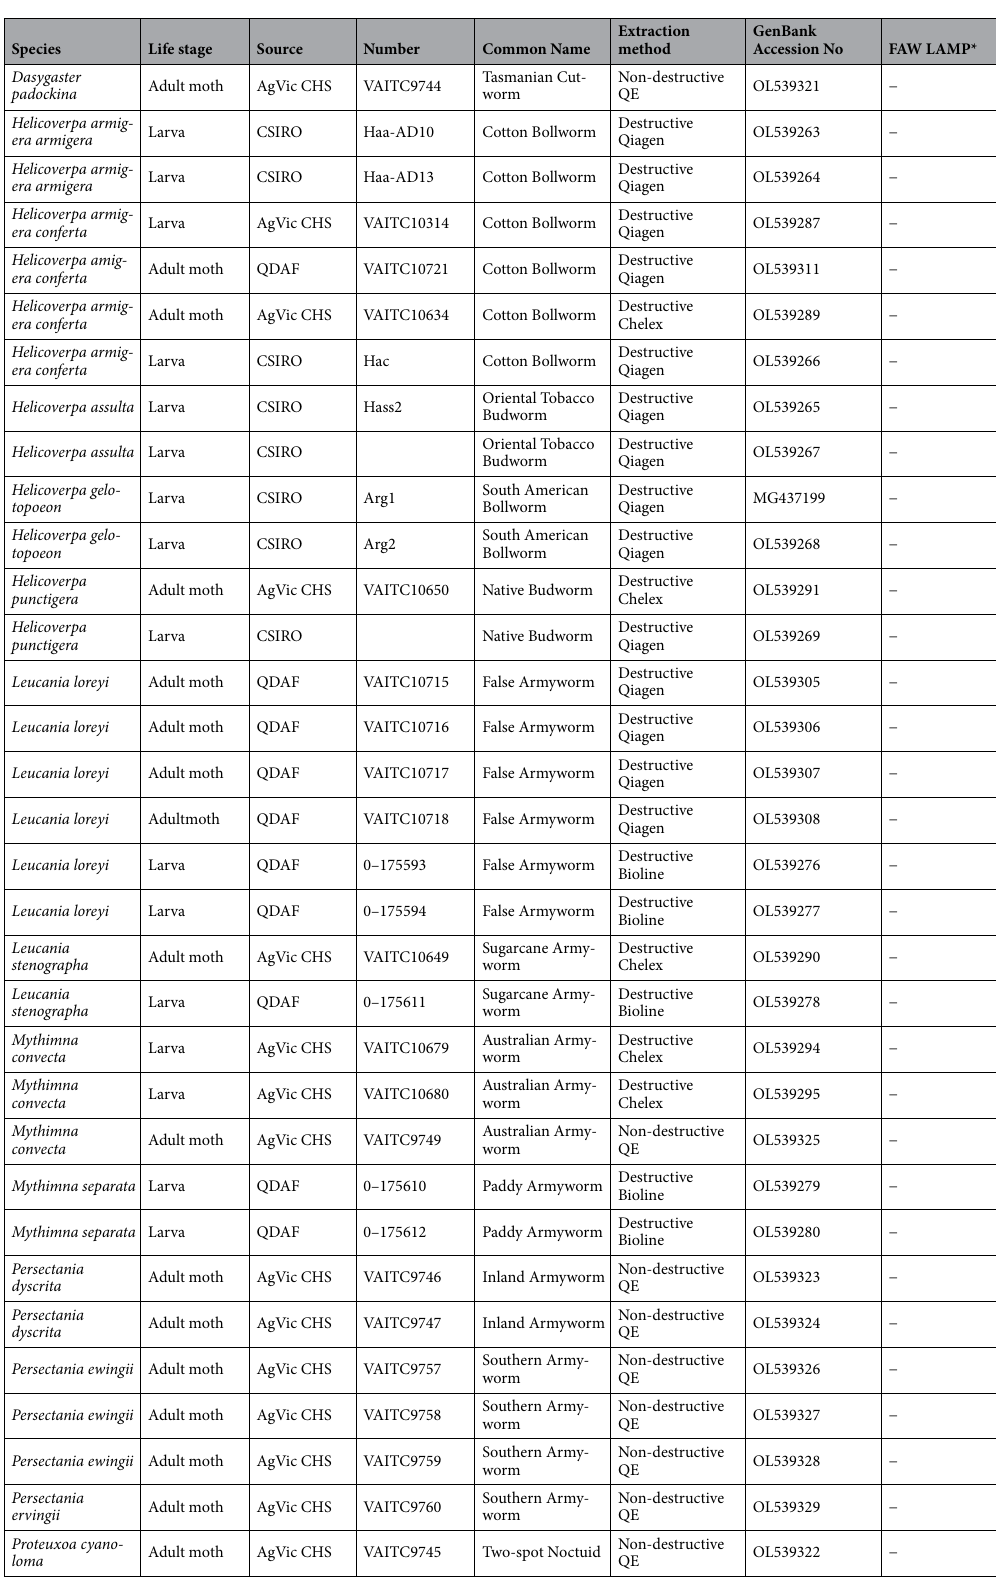
Table 2. Panel of Noctuidae (Lepidoptera) specimens tested for the FAW LAMP assay. Bold indicates the target species. “ + ” indicates FAW LAMP amplification within 20 min, “−“ indicates no amplification. AgVic CHS, Agriculture Victoria Crop Health Services; CSIRO, Commonwealth Scientific and Industrial Research Organisation; DAWE, Department of Agriculture Water and Environment; QDAF, Department of Agriculture and Fisheries Queensland; QE, QuickExtract. *See